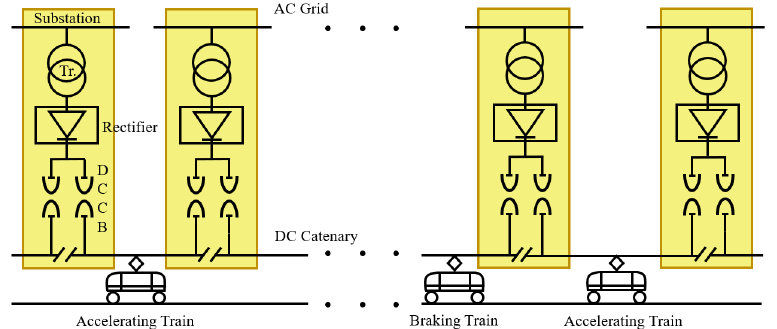
Figure 2. Schematics of simple DC power traction system.